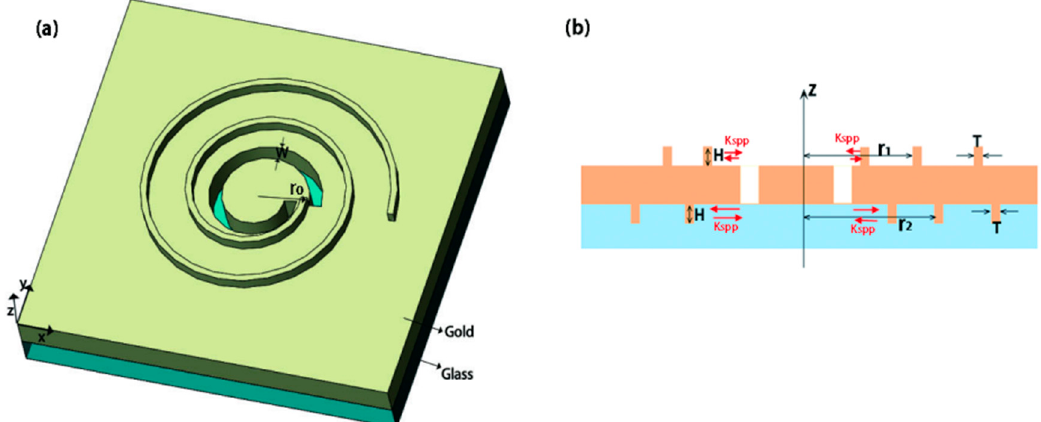
Figure 10. Schematic diagram of the proposed structure under the illumination of the circular polarization plane wave along the positive z-direction (from glass side); ( a ) a single-turn left-hand spiral slit surrounded by Archimedes’ spiral gold grating on both sides of the metal film; ( b ) lateral view of the structure along the location of the line depicted in ( a ). The red arrows represent the propagation of SPPs. The incident light is coupled into SPPs through the spiral slit, and the SPPs generated from the corresponding slits at each side have the opposite direction of propagation. The spiral gratings reflect part of the SPP wave due to Bragg reflection. Reproduced with permission from [28]. Copyright Springer,